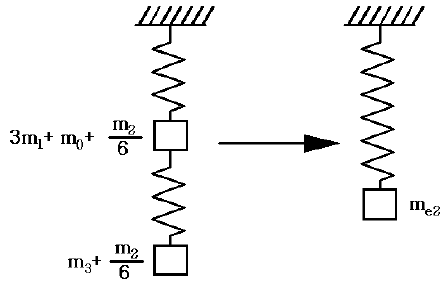
Figure 6. Spring-mass-damper diagram.